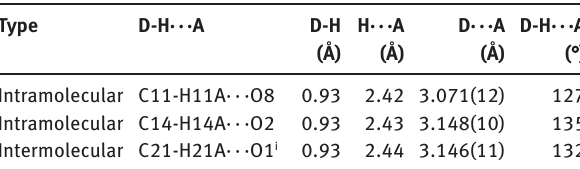
Table 2: H-Bonding geometry parameters (Å and deg) for the compound.